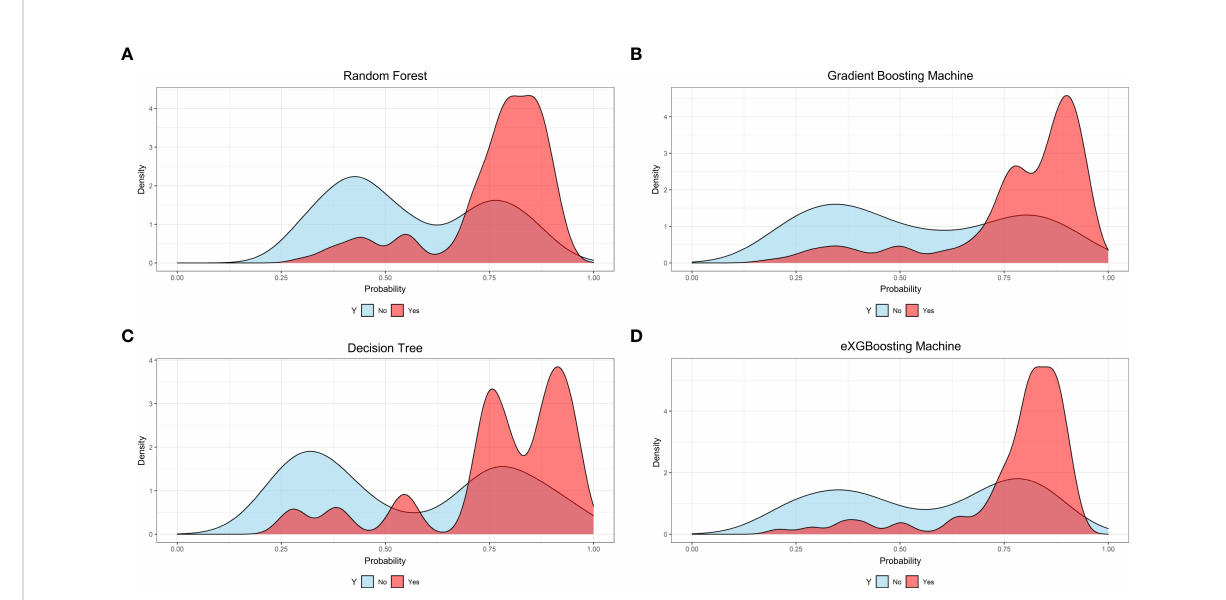
FIGURE 4 Probability curves for each approach. (A) Random Forest; (B) Gradient Boosting Machine; (C) Decision Tree; (D) eXGBoosting Machine.